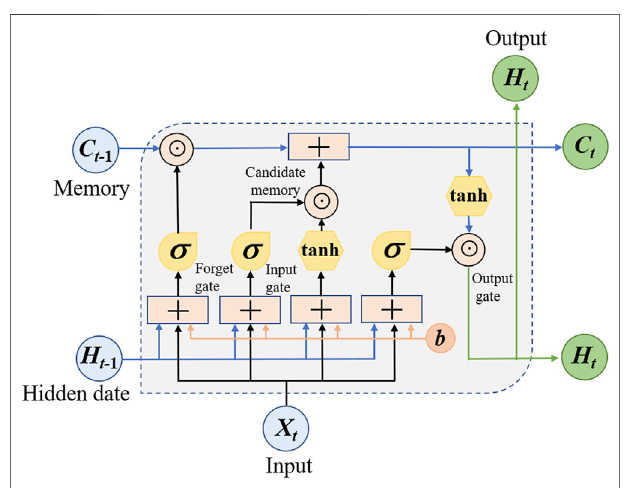
FIGURE 4 | Basic cell of